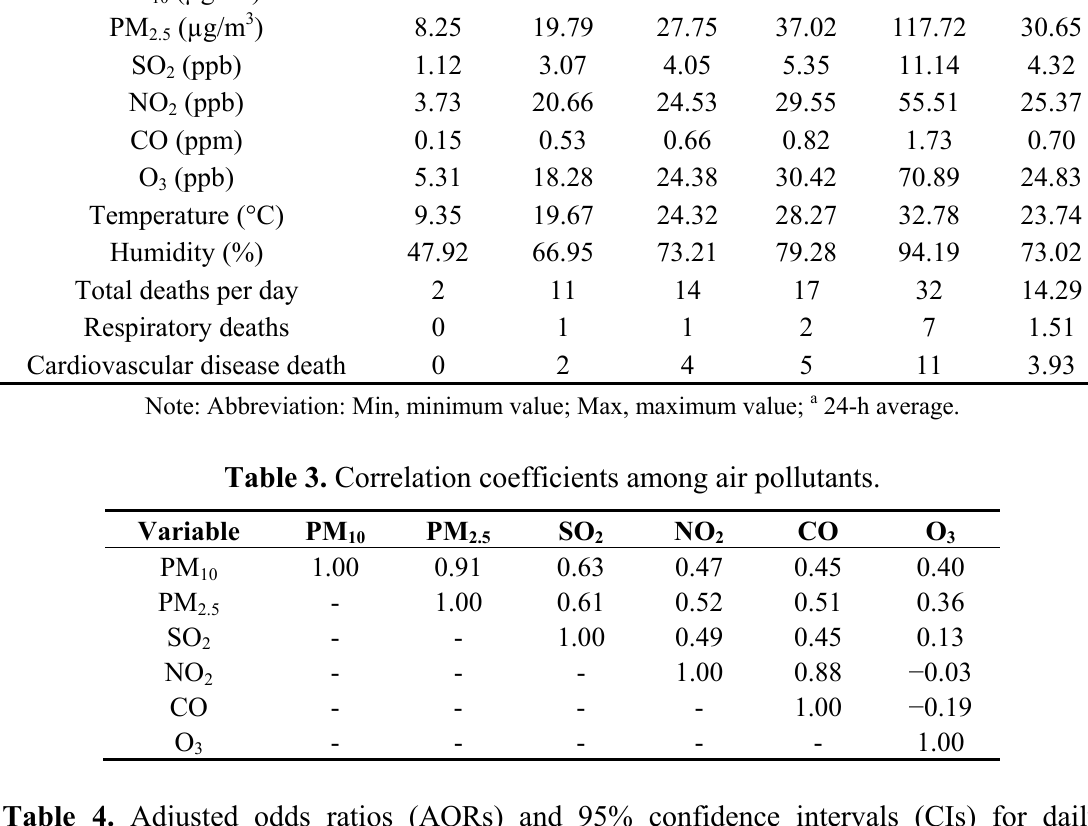
in Taipei, Taiwan, 2006–2008, 2.5